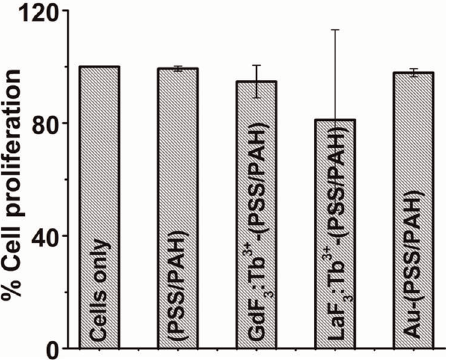
Figure 10. In vitro biocompatibility of nanoparticles-loaded PSS/PAH capsules. MTT assay results of HeLa cells, blank PSS/PAH capsules, GdF 3 :Tb 3 + (5%), LaF 3 :Tb 3 + (5%), and Au nanoparticles-loaded PSS/PAH capsules on incubation with HeLa